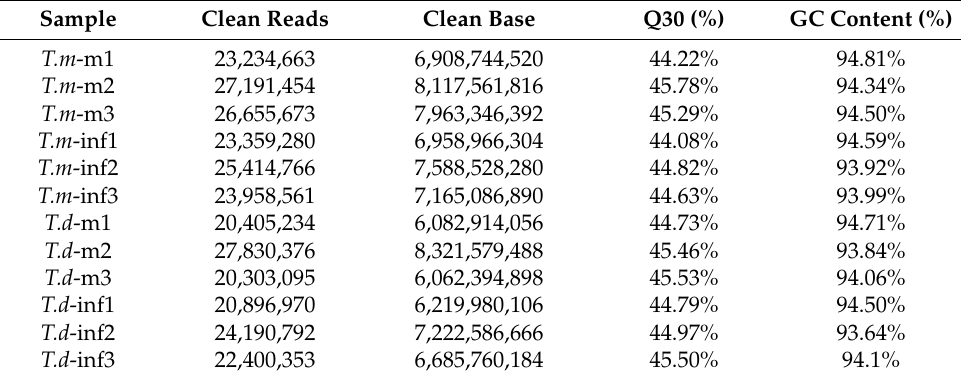
Table 1. Summary of Illumina transcriptome sequencing for different